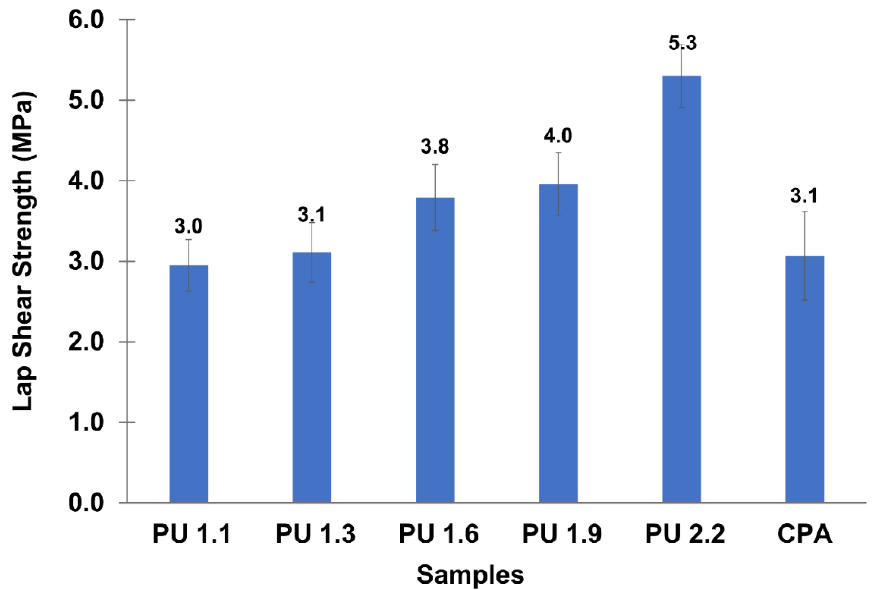
Figure 3. Effect of NCO/OH ratio on average lap shear strength of the lignin-based PU adhesives compared with CPA .